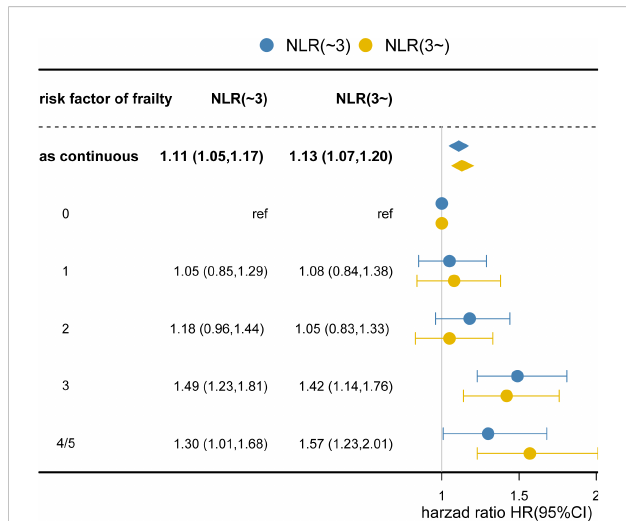
FIGURE 2 Degree of Failty at Admission and Overall Survival. Each additional frailty component present at admission increased hazard of death by 11% (hazard ratio [HR], 1.11; 95% CI, 1.05-1.17; P <0.001) for NLR<3 and 13% (HR: 1.13; 95% CI, 1.07-1.20; P<0.001) for NLR ≥ 3. Cox regression models adjusted for age, gender, body mass index, smoking, alcohol, tumor location, tumor stage, chemotherapy, radiotherapy, surgery, nutrition intervention, ECOG, PG-SGA, Place of Residence, Educational attainment, hand grip strength, EORTC QLQ ‐ C30. Number of risk factors indicates the number of abnormal frailty components present at admission. The reference group had 0 frailty risk